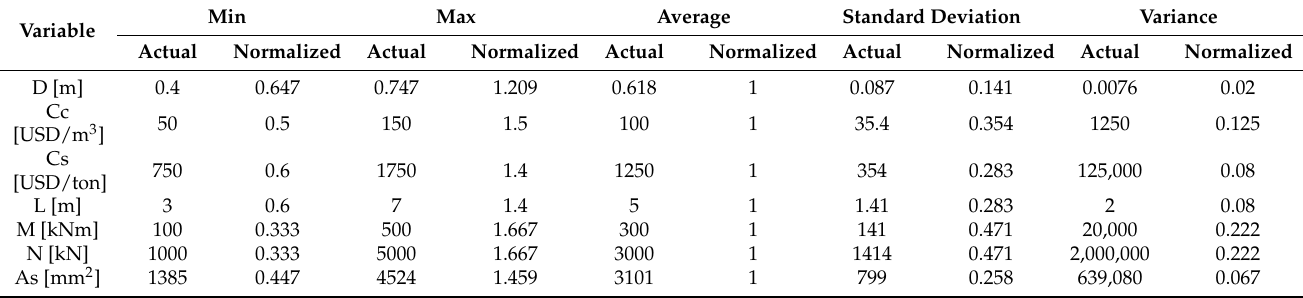
Figure 3. Design variable ranges in the dataset. Table 1. Variable ranges and statistical properties.